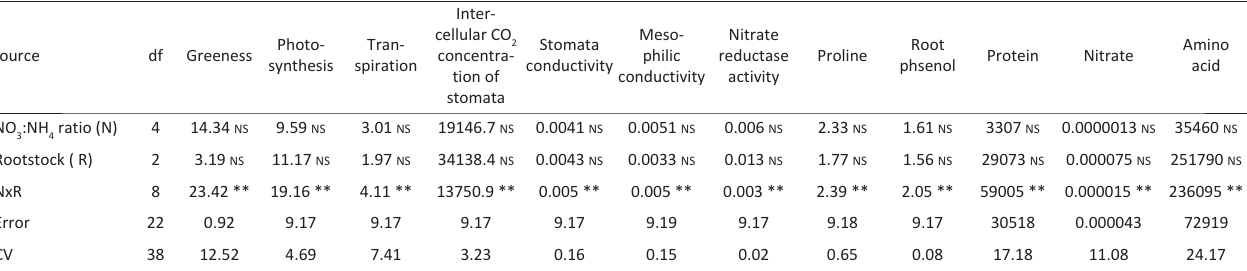
NS , *, ** not significant or significant at 5% or